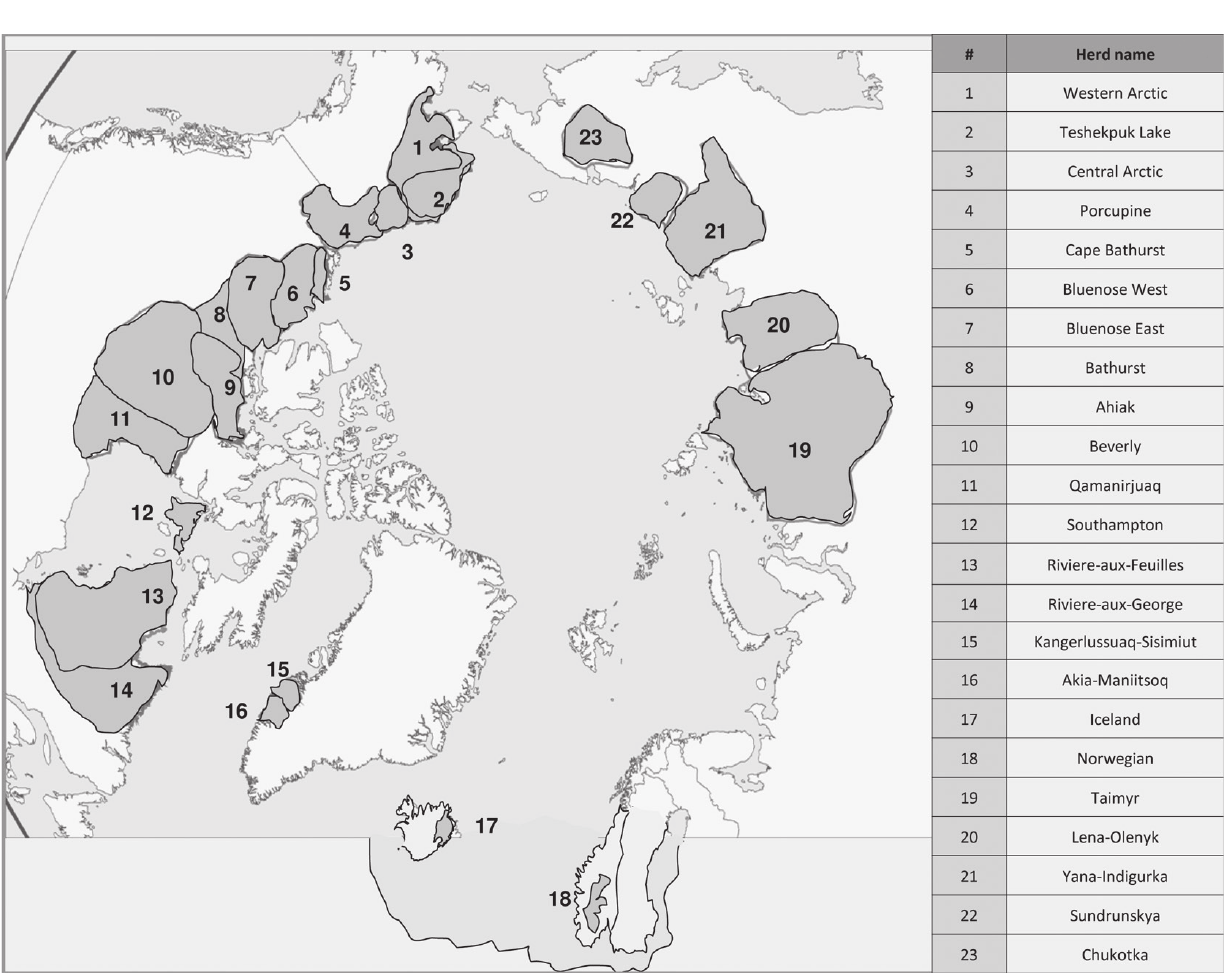
Fig. 1. Distribution of migratory Rangifer tarandus